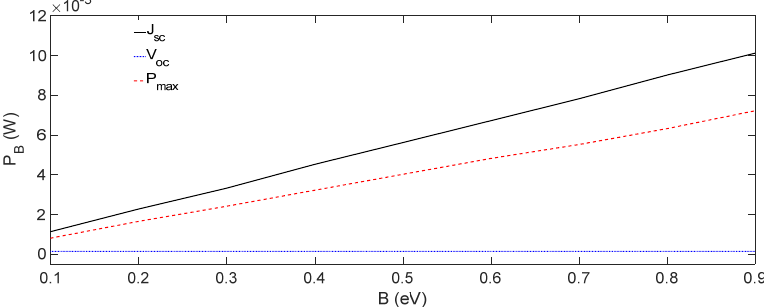
Figure 9. 𝑃 (cid:3003) plotted as function of 𝐵 at 𝐽 (cid:3046)(cid:3030) , 𝑉 (cid:3042)(cid:3030) , and 𝑃 (cid:3040)(cid:3028)(cid:3051) conditions. Figure 9. P B plotted as function of B at J sc , V oc , and P max